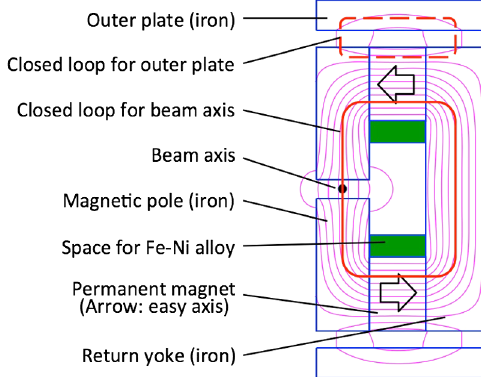
FIG. 1. A magnetic circuit for an adjustable-field C-shaped dipole magnet. The red solid curve represents a closed loop of the magnetic flux for the beam axis. The red dashed curve is for leaked flux. The arrows show easy axes of permanent magnet pieces. The green squares are spaces for Fe-Ni alloys (see Sec. II